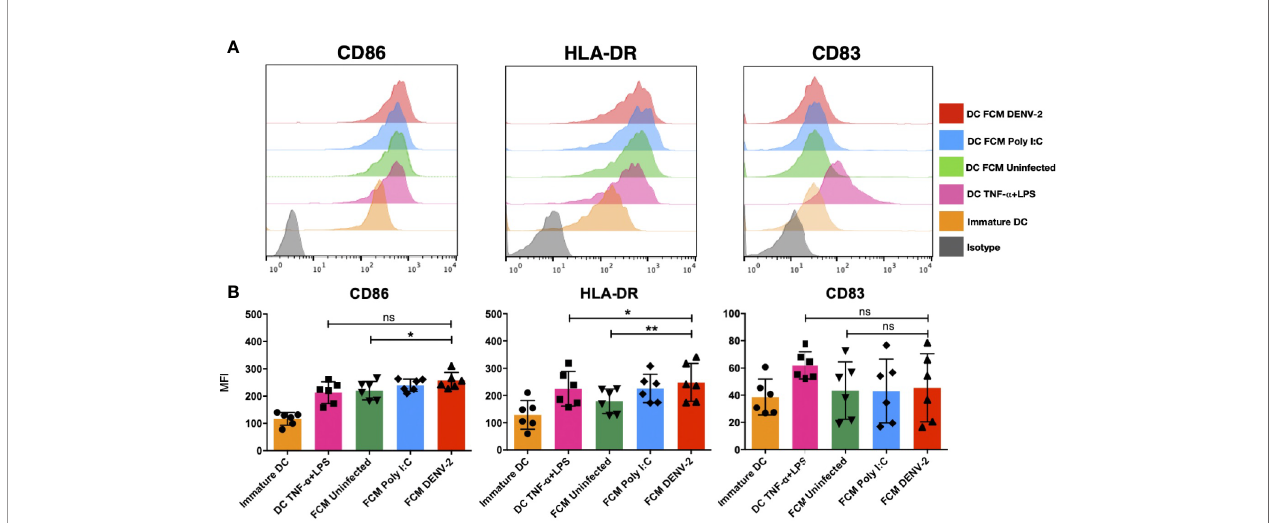
FIGURE 2 | Fibroblasts ’ conditioned media promote the partial maturation of moDC. Conditioned media of uninfected (UI), Poly I:C transfected (PIC), or DENV-2 infected fi broblasts was used to treat immature moDC for 24 hours. Maturation markers were evaluated using fl ow cytometry. Controls included moDC cultured without stimulus and stimulated with TNF- a +LPS. (A) Representative histograms of the maturation markers CD86, CD83, and HLA-DR. (B) Mean fl uorescence intensity (MFI) of the maturation markers evaluated for all six donors. Error bars indicate the standard deviations for the three independent experiments of each donor; n = 6. ns, no signi fi cant. *P < 0.05 and **P < 0.01.